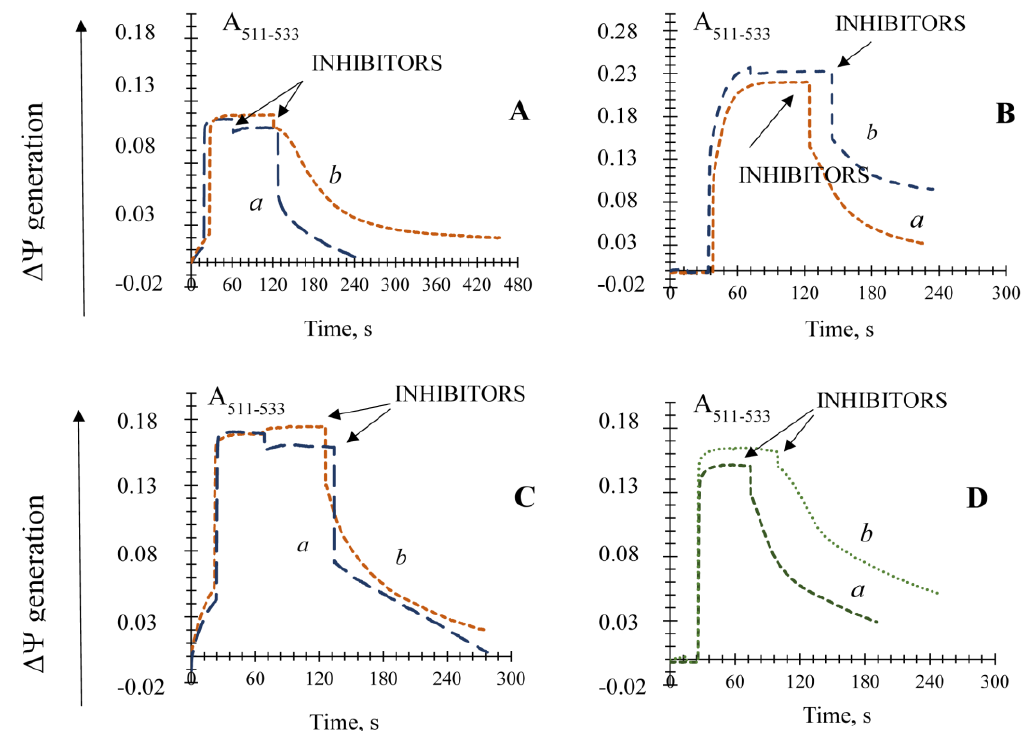
Figure 4. Effects of AN and the inhibitors of the ANT on the non-specific permeability transition induction in the E. magnusii mitochondria respiring on a pyruvate and malate system. (Panel ( A )); α ketoglutarate (Panel ( B )), and succinate (Panel ( C )) in the presence of the antioxidant enzyme inhibitors. The basic incubation medium also contained 150 µ M ATP (trace a) and 150 µ M ADP (trace b). (Panel ( D )) the incubation medium also contained 0.4 µ M CATR (trace a) and 40 µ M BA (trace b). The addition of the inhibitors mixture (4 mM DDC and 4 mM ATZ) is indicated by the arrows.